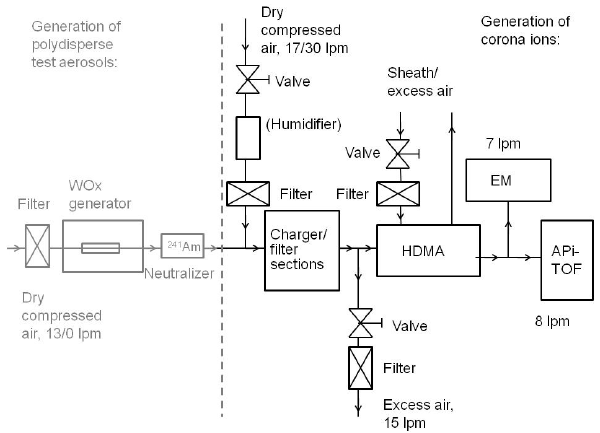
Figure 2. A schematic layout of the experimental set-up. The layout printed in black was used 498 Fig. 2. A schematic layout of the experimental set-up. The layout to investigate the corona-generated ions and the part printed in gray was used when the WOx 499 printed in black was used to investigate the corona-generated ions particles were introduced to the system to be charged by the corona ions. 500 and the part printed in gray was used when the WOx particles were introduced to the system to be charged by the corona